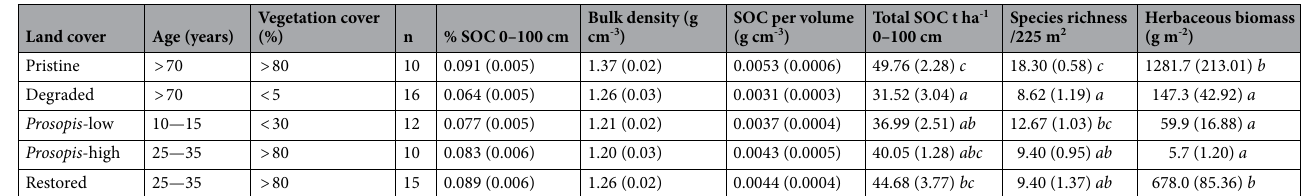
Table 1. Sampling sites characteristics and mean (Standard Error) of the various variables per land cover type. Land cover types sharing a letter are not significantly different at α = 0.05. Age was estimated using a combination of information sources and criteria such as literature review 95–97 , time series maps for the study area 31 , and consultations with key informants in the study area. Vegetation cover was determined using Prosopis fractional cover map for Prosopis plots, as well as land use/land cover maps 31 and field observations for the other land cover